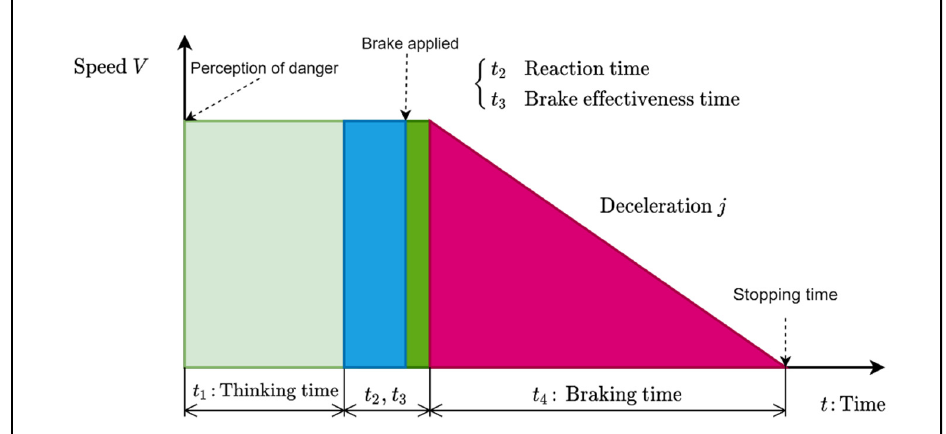
Figure 6. Stopping distance dynamics when the driver perceives a danger. The braking time 𝑡 (cid:2872) is affected by different factors such as the braking force, tire state, tire type, and friction force.